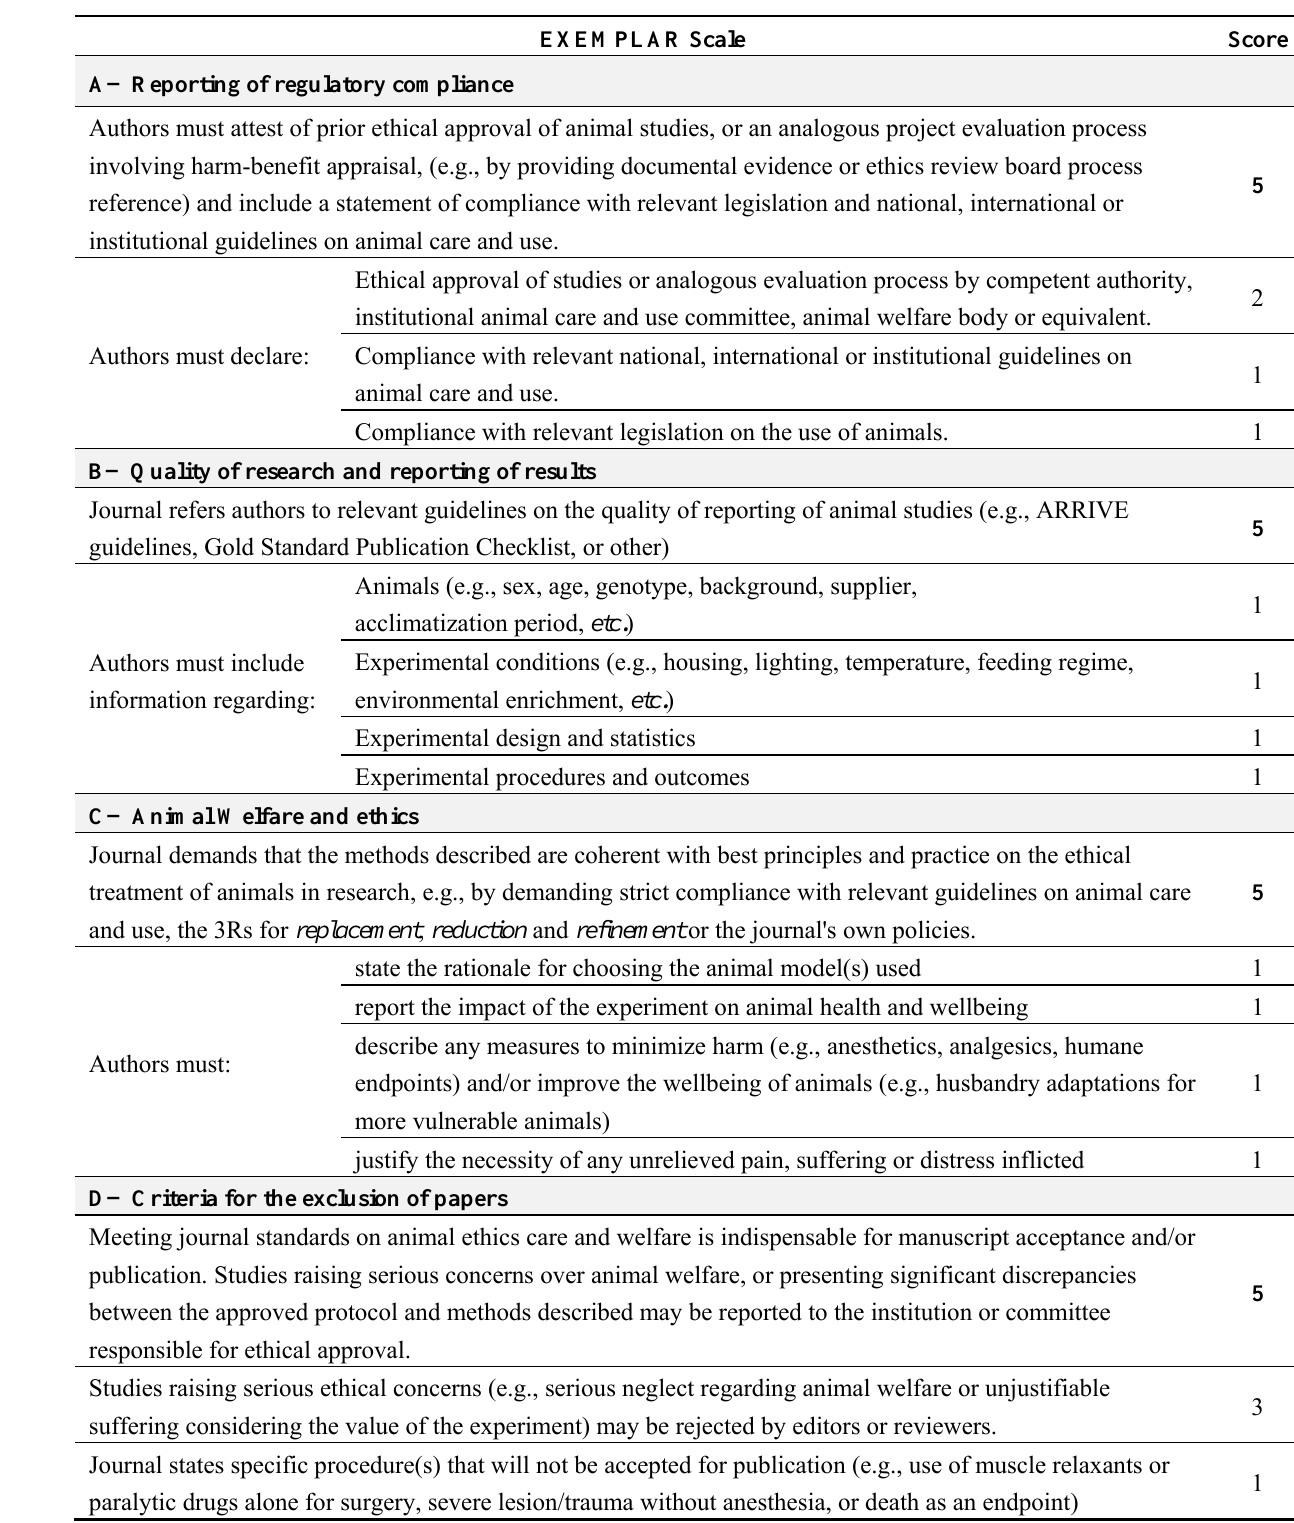
Table 1. The Excellence in Editorial Mandatory Policies for Animal Research (EXEMPLAR)